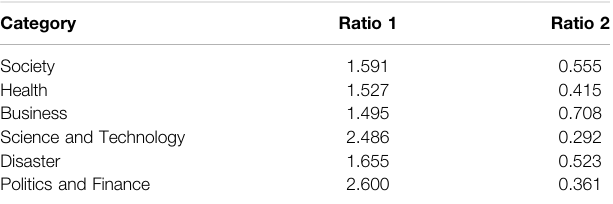
TABLE 4 | Relative proportion of account types in DPs and those in NDPs under six types of fake